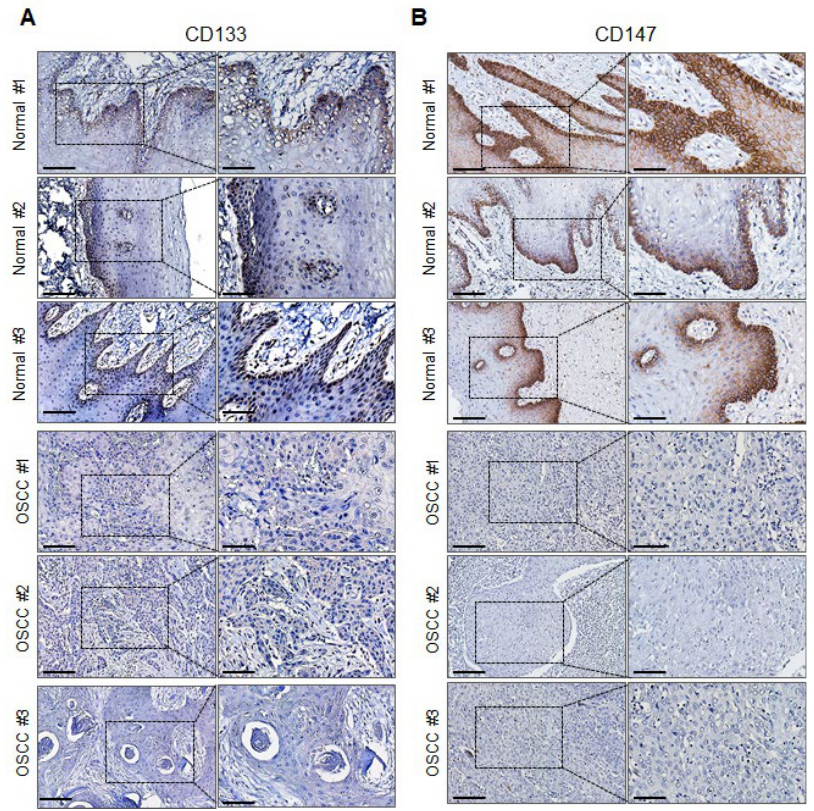
Figure 5. Protein expression levels of CD133 and CD147 in primary OSCC tumors and normal oral mucosal tissue samples. The representative immunohistochemical analysis results show ( A ) CD133 and ( B ) CD147 expression in primary OSCC tissues and normal oral mucosal tissues (left images: × 40, scale bar, 50 μm; right images: × 20, scale bar, 100